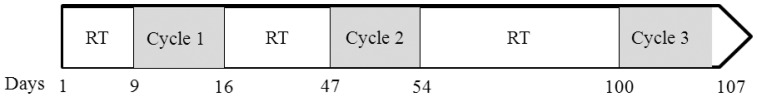
Schematic diagram of the time sequence for the three temperature-change cycles.RT signifies that the soil samples were incubated at room temperature.